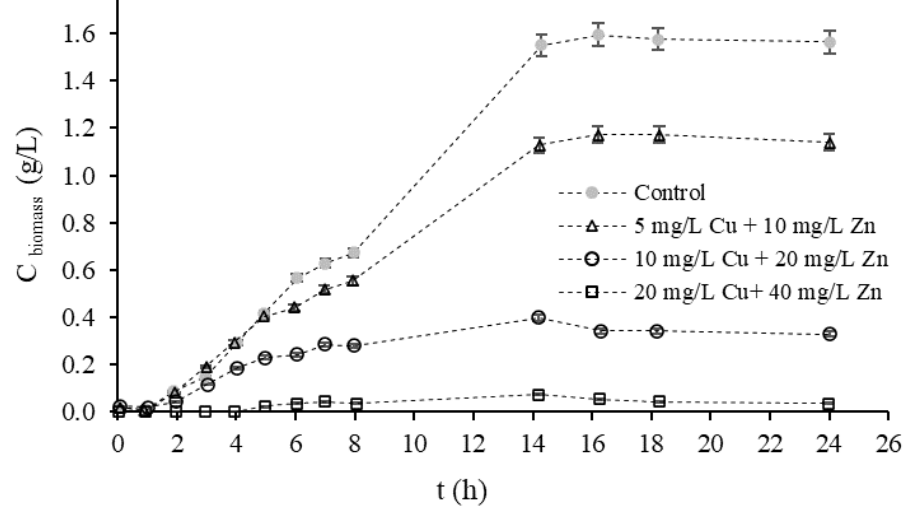
Figure 3. Toxicity assessment of heavy metals. Biomass concentration along time for different initial concentrations of Cu and concentrations of Cu and Zn.